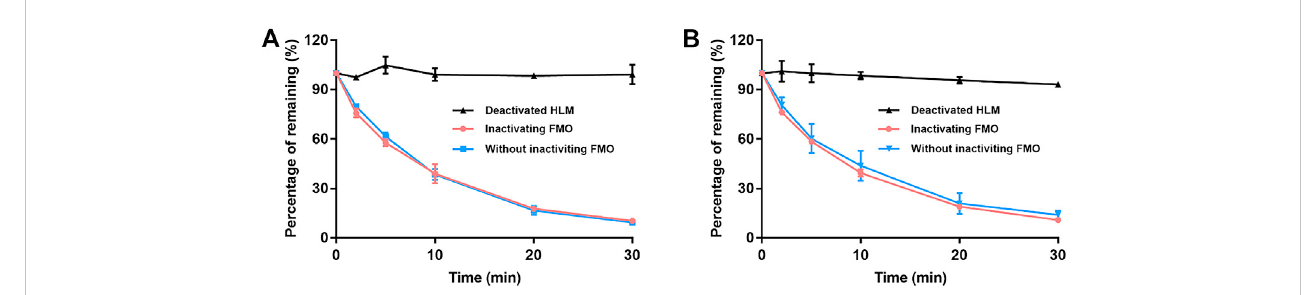
FIGURE 3 The contribution of FMO to EA (A) and EB (B) metabolism in HLMs with NADPH. Deactivated HLMs were used as negative control (mean ± SD; n =